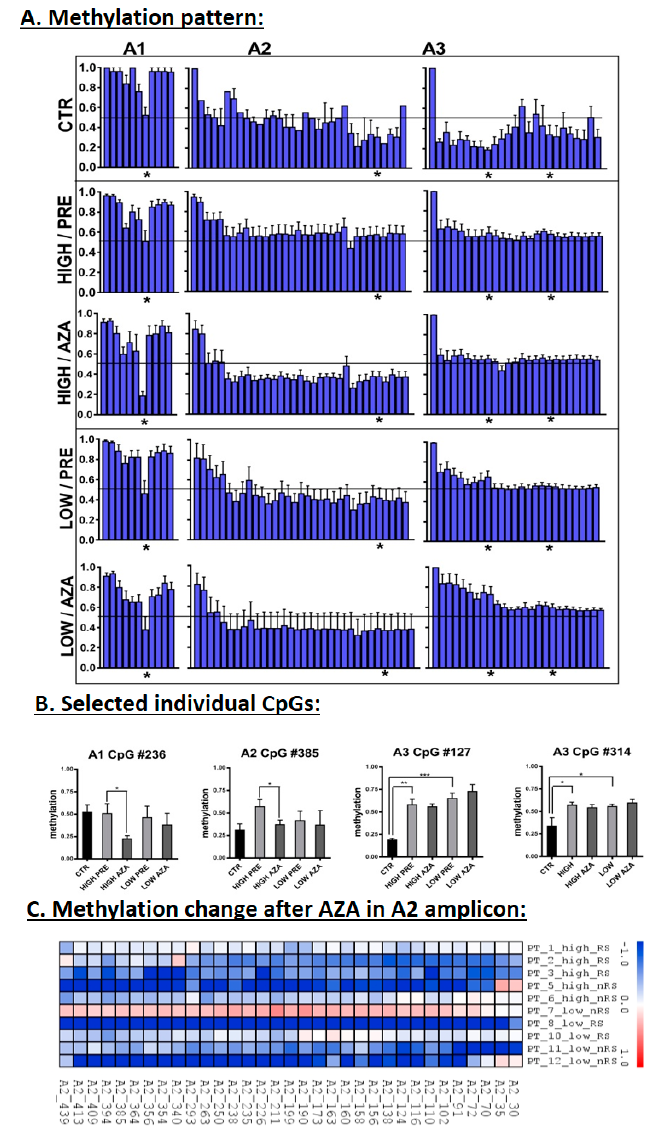
Figure 4. DNA methylation of the MEG3 -DMR. ( A ) Average methylation profiles examined in the A1–A3 amplicons. Samples were separated into one control group (CTR) and four patient groups that